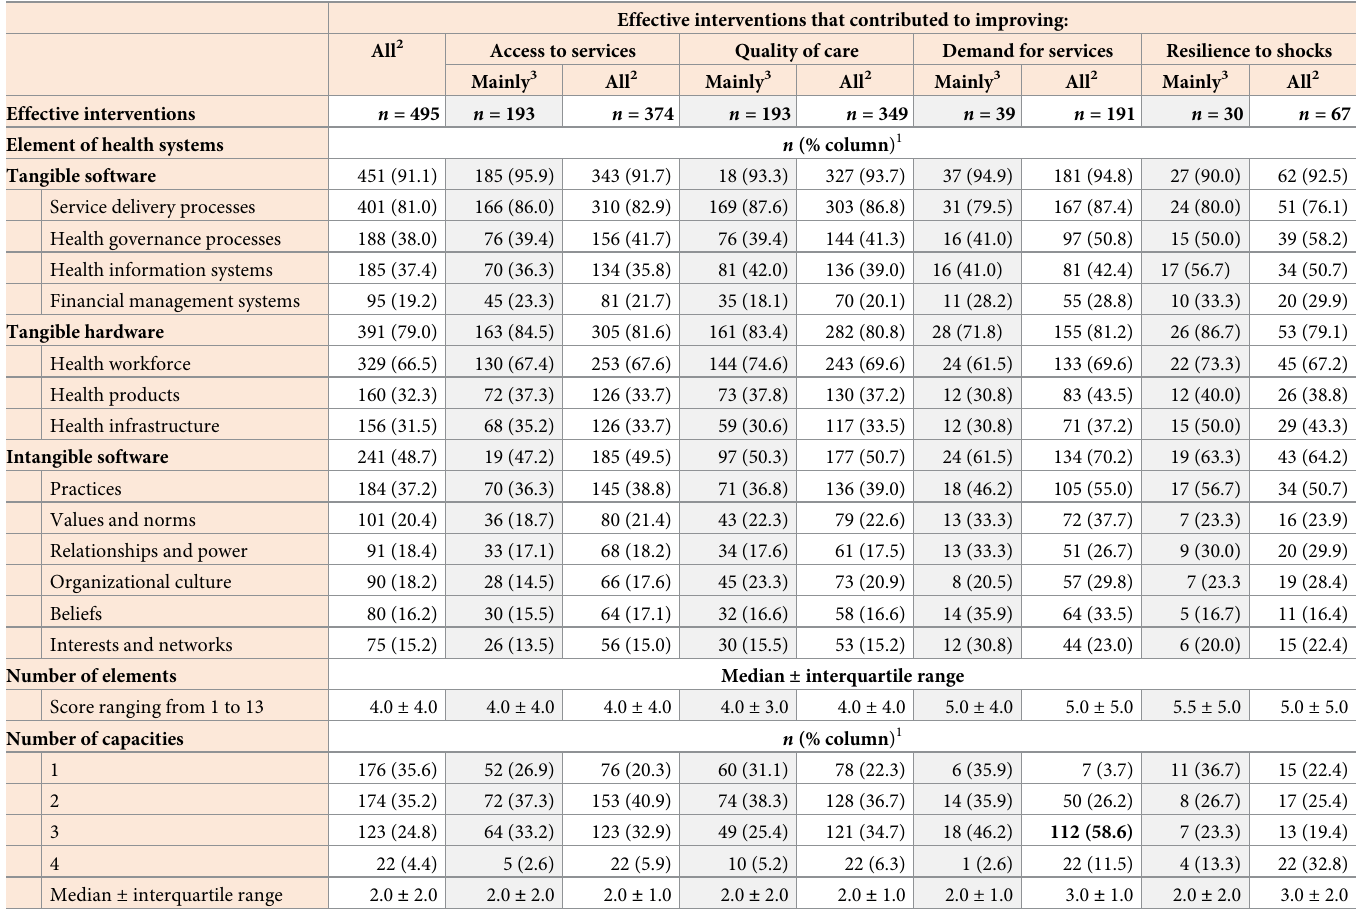
Table 3. Characteristics of effective